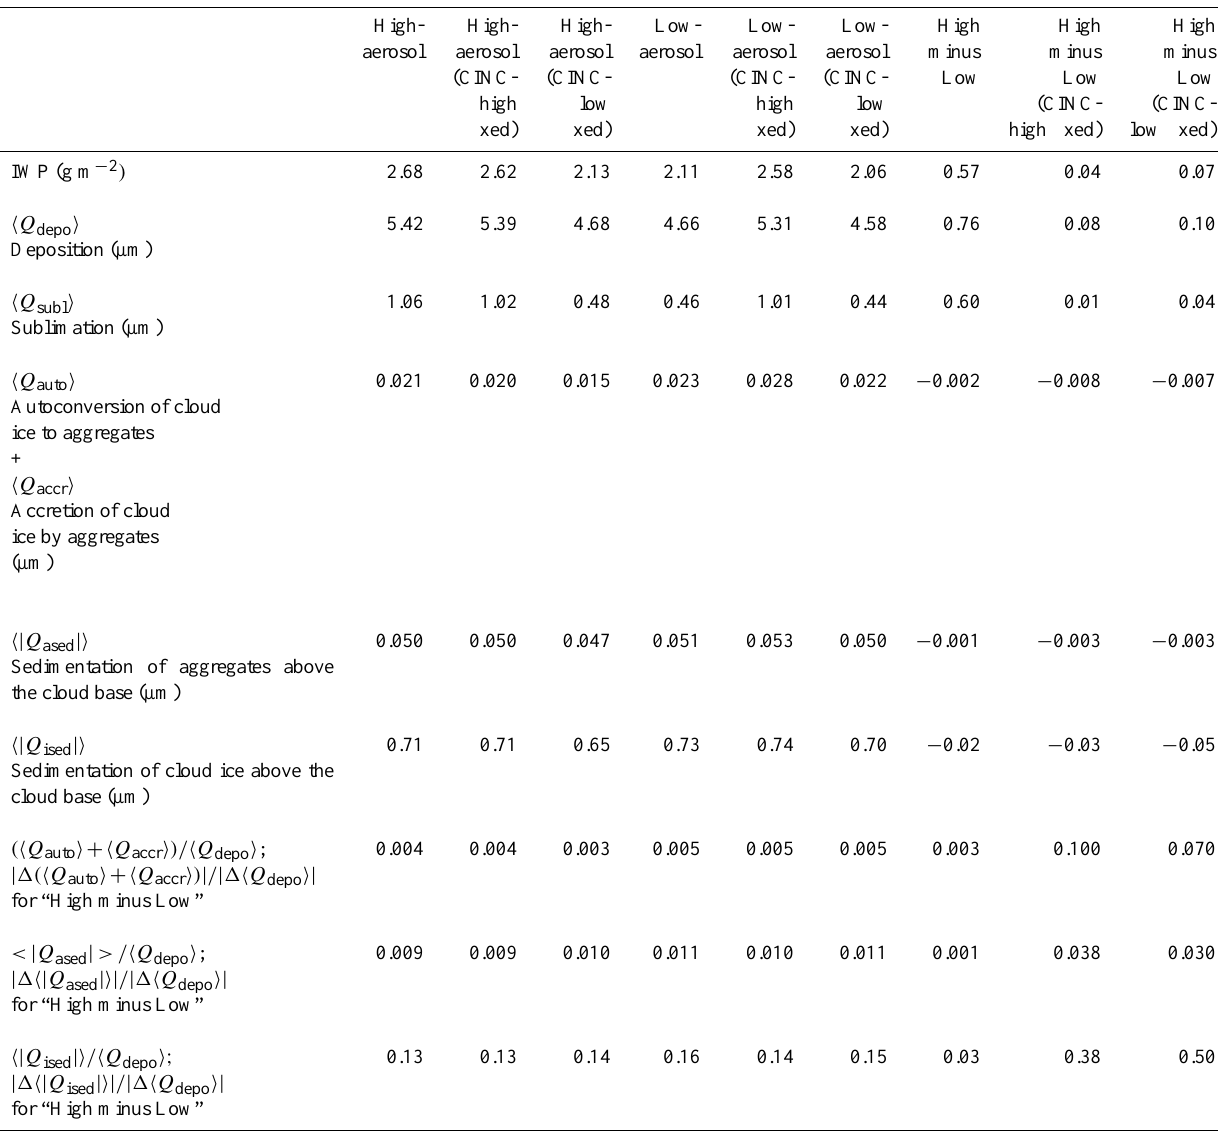
Table 1. Domain-averaged budget terms of cloud